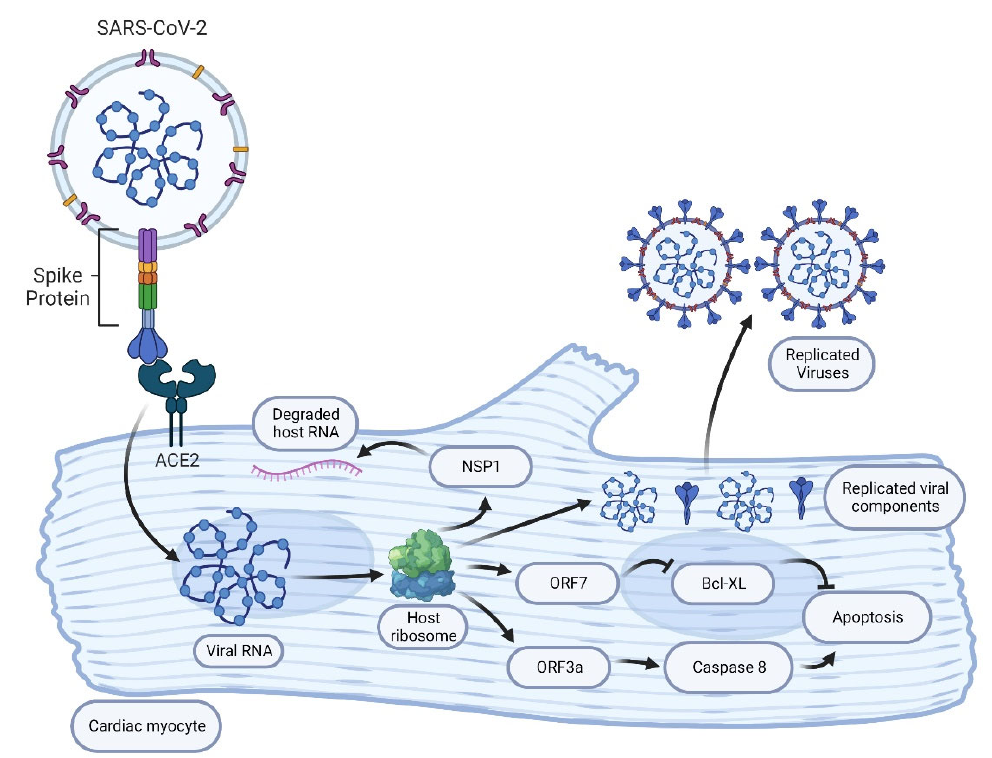
Figure 1. Direct myocyte damage from COVID-19 infection. The COVID-19 virus is brought into the cell when the spike protein binds to the ACE2 receptor. The viral RNA is exposed and then replicated by host ribosomes to produce new viral components. In the case of COVID-19, replicated viruses bud out from the host plasma membrane, rather than requiring cell lysis. Replication of the COVID-19 virus occupies host ribosomes and consumes host resources needed for normal cell function, leading to cell damage. Replication of viral RNA also produces non-structural protein 1 (NSP1) which degrades host RNA to allow more processing of viral RNA. Viral RNA production releases open reading frame 7 (ORF7) which inhibits B-cell lymphoma-extra-large (Bcl-XL), an inhibitor of apoptosis. Open reading frame 3a (ORF3a) is also produced and initiates apoptosis through activation of caspase-8. These open reading frames together initiate host cell apoptosis and inhibit pro-survival pathways. Figure created with BioRender.